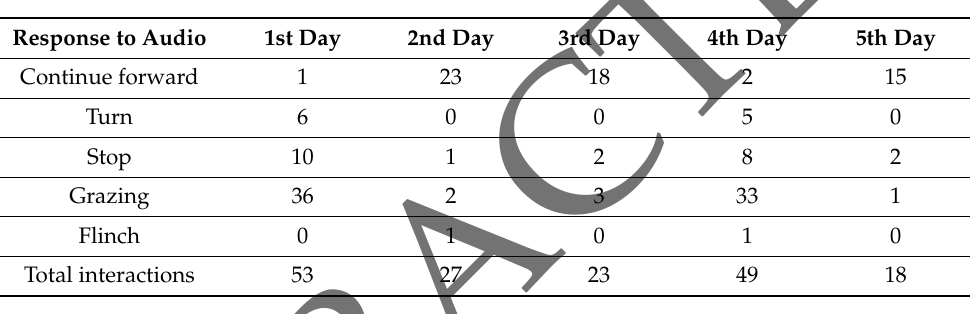
Table 5. Count of behaviors from a goat, presented in response to the audio cues over the five days the virtual fence was experimented.